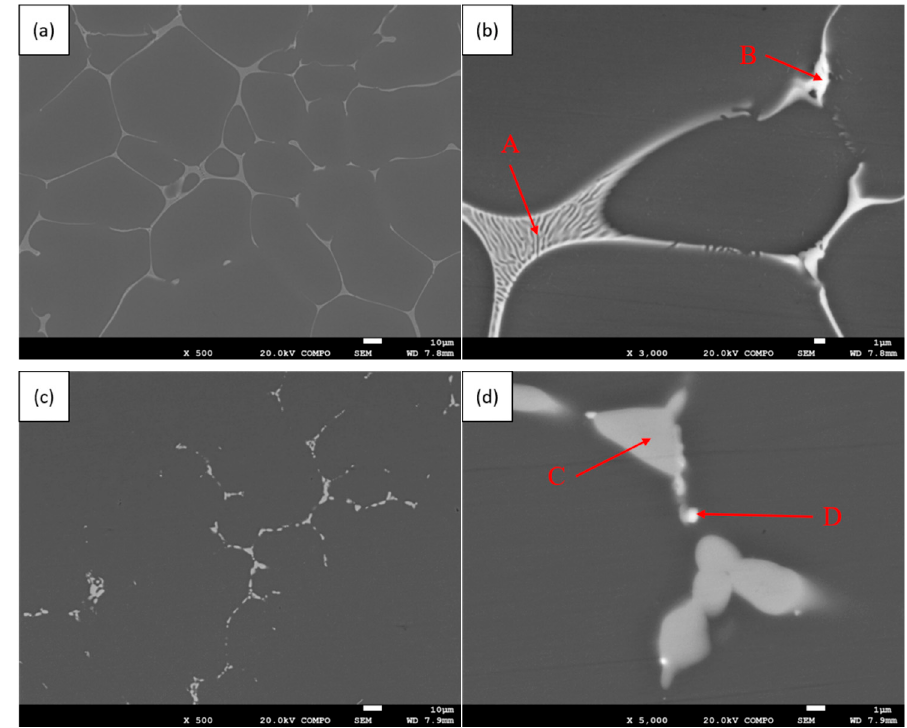
Figure 7. Scanning electron microscope photos of 1# in different heat treatment states, ( a , b ) as-cast, ( c , d ) TST-T6.